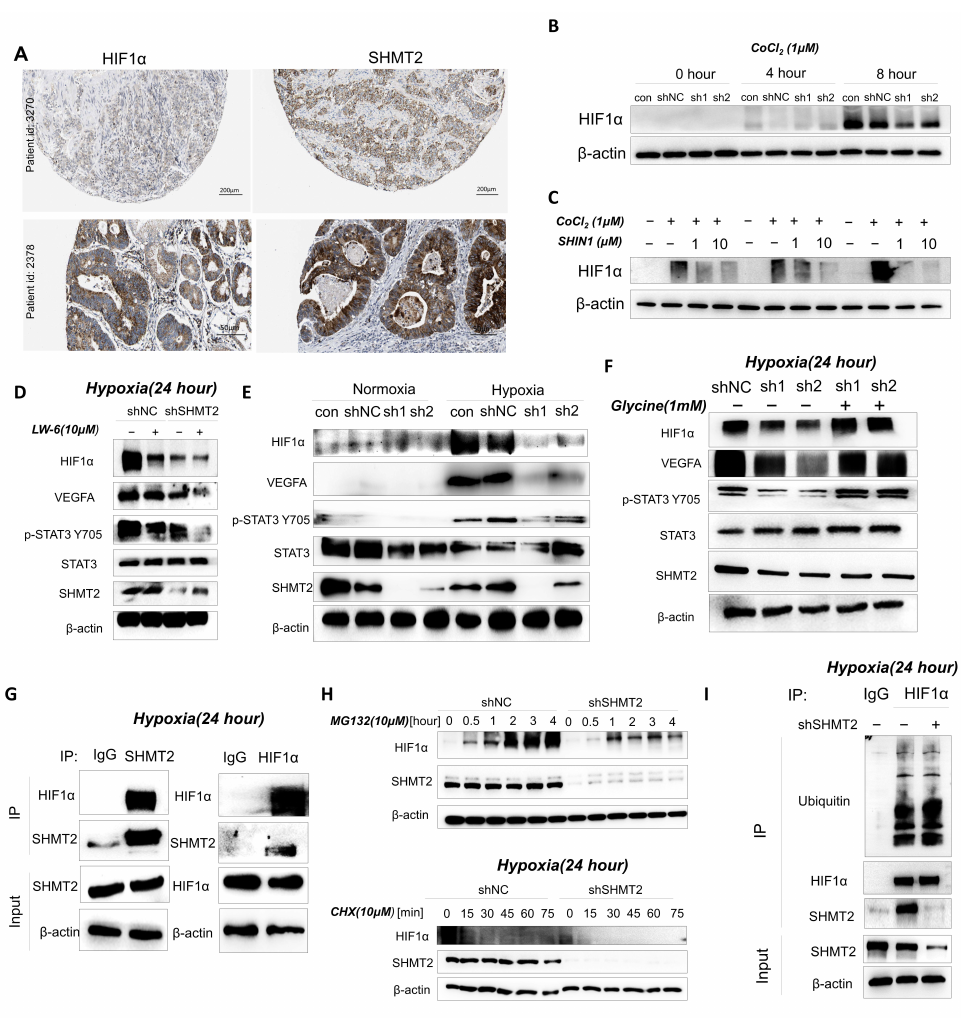
Figure 6. SHMT2 knockdown inhibited the HIF1 α /VEGFA/STAT3 signaling pathway. ( A ) Repre- sentative IHC staining for SHMT2 and HIF1 α in normal gastric tissues and tumor tissues of GC patients from the Human Protein Atlas database. Scale bar: 200 µ m and 50 µ m. ( B ) Western blot analysis of intracellular HIF1 α , VEGFA, and β -actin after stimulation with CoCl 2 (1 µ M) in shSHMT2 SGC7901 cells. ( C ) Western blot analysis of intracellular HIF1 α , VEGFA, and β -actin in SGC7901 cells stimulated with CoCl 2 (1 µ M) in the presence of DMSO or SHIN1 for 6 h. ( D ) Western blot analysis of intracellular HIF1 α , VEGFA, p-STAT3 (Y705), STAT3, SHMT2, and β -actin under hypoxia with LW-6 (10 µ M) in shNC and shSHMT2 group. ( E ) Western blot analysis of HIF1 α , VEGFA, p-STAT3 (Y705), STAT3, SHMT2, and β -actin in SGC7901 cells under normoxic and hypoxic conditions after SHMT2 knockdown. ( F ) Western blot analysis of HIF1 α , VEGFA, p-STAT3 (Y705), STAT3, SHMT2, and β -actin in shSHMT2 cells after glycine (1 mM) back completion. ( G ) Coimmunoprecipitation assay of SHMT2 and HIF1 α in SGC7901 cells after hypoxic stimulation of cells for 24 h. ( H ) Western blot of HIF1 α in shNC and shSHMT2 cells treated with MG132 (10 µ M) and CHX (10 µ M). ( I ) Ubiquitination assay of SHMT2 and HIF1 α in shNC and shSHMT2 cells after 24 h of hypoxic